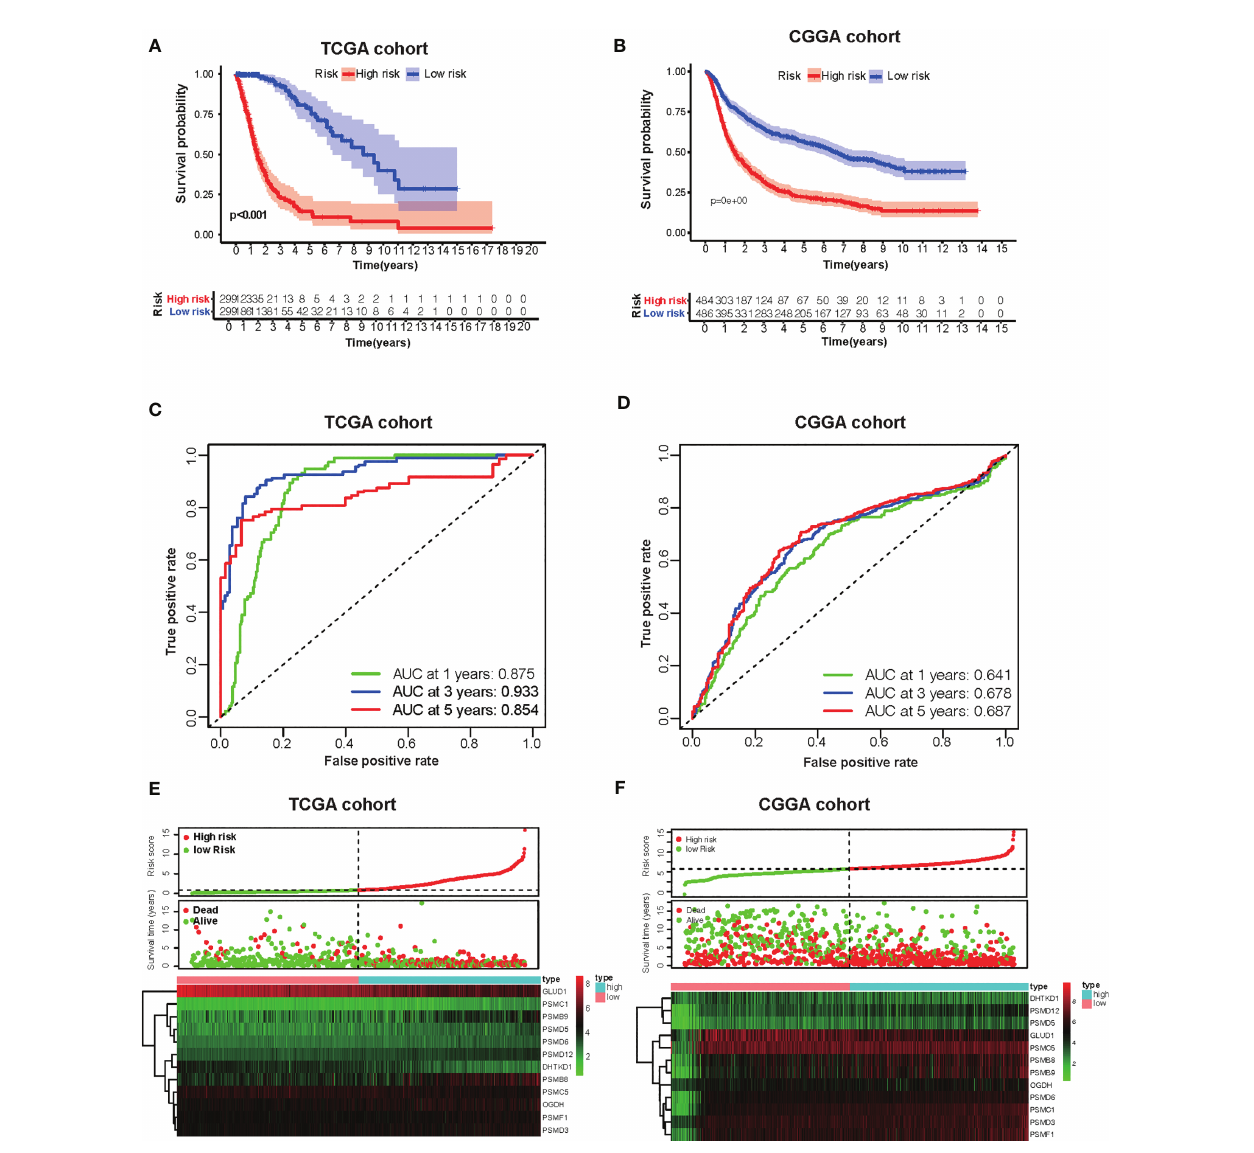
FIGURE 5 | Development of the risk score signature and assessment of the predicting capacity. (A, B) Survival curves of patients in the high-risk group and the low-risk group of The Cancer Genome Atlas (TCGA) glioma and Chinese Glioma Genome Atlas (CGGA). Patients in the high-risk group suffered shorter overall survival. (C, D) Survival-dependent receiver operating characteristic (ROC) curves validation at 1, 3, and 5 years of prognostic value of the prognostic index in the two databases (TCGA and CGGA, respectively). (E, F) The distribution of risk score, overall survival (OS), gene expression in TCGA, and CGGA databases is also shown. The distribution of risk score, OS, and heat map of the expression of 12 genes in the low- and high-risk groups are shown in the picture from top to